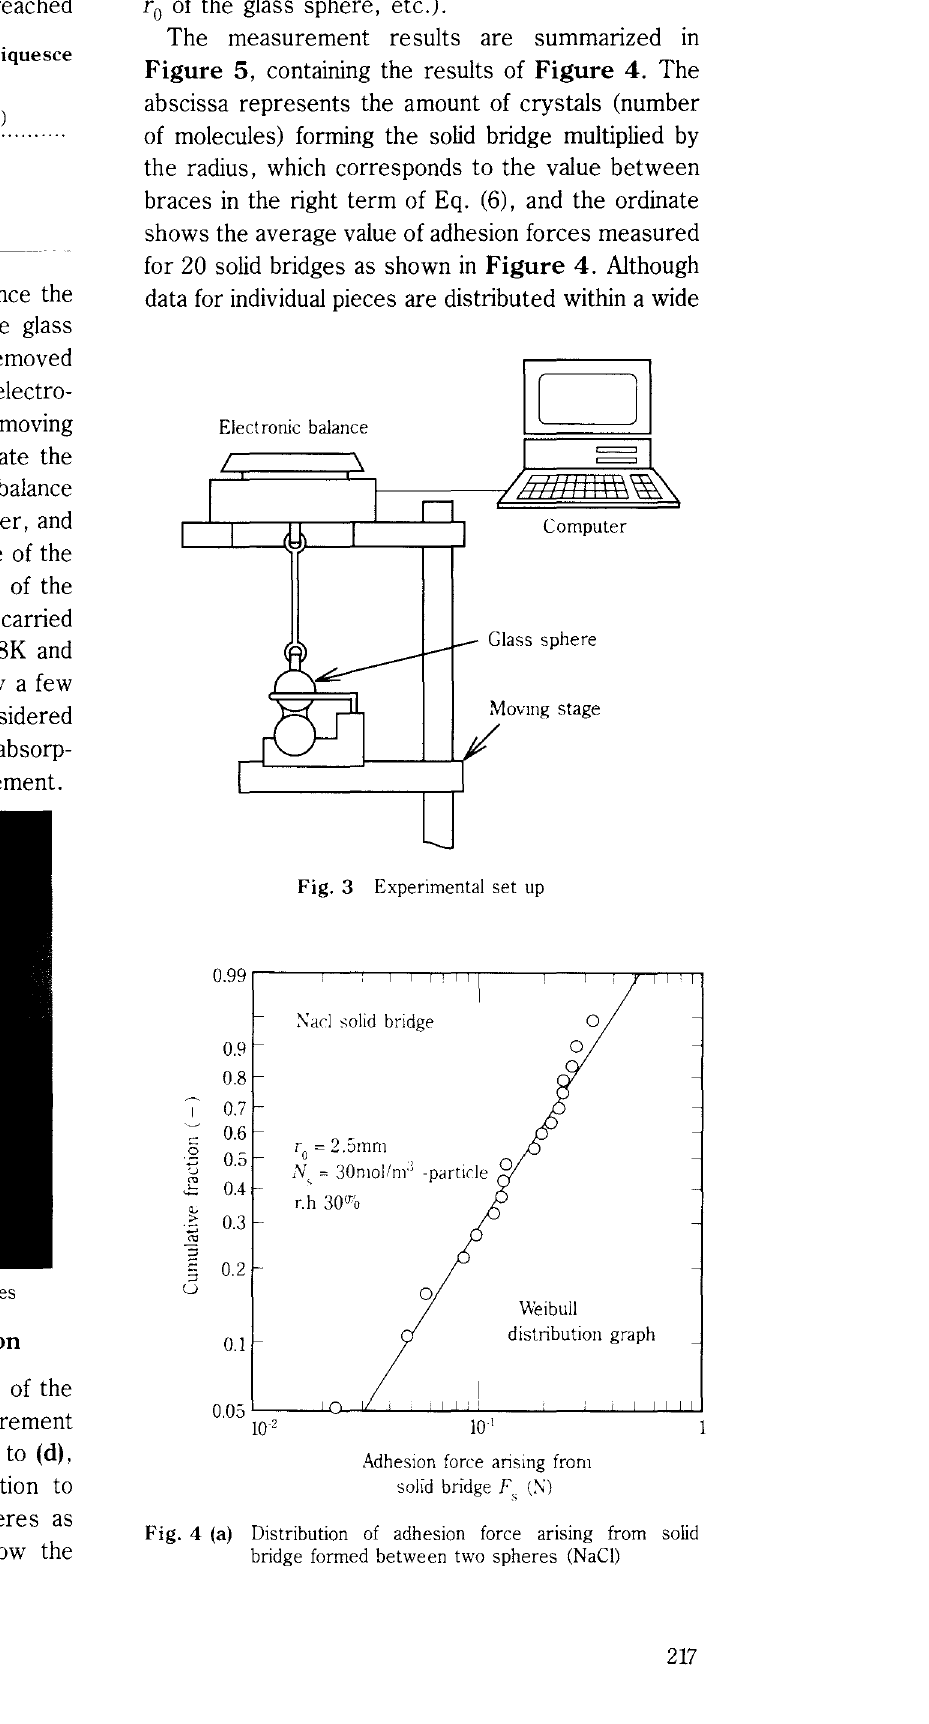
Fig. 4 (a) Distribution of adhesion force arising from solid bridge formed between two spheres